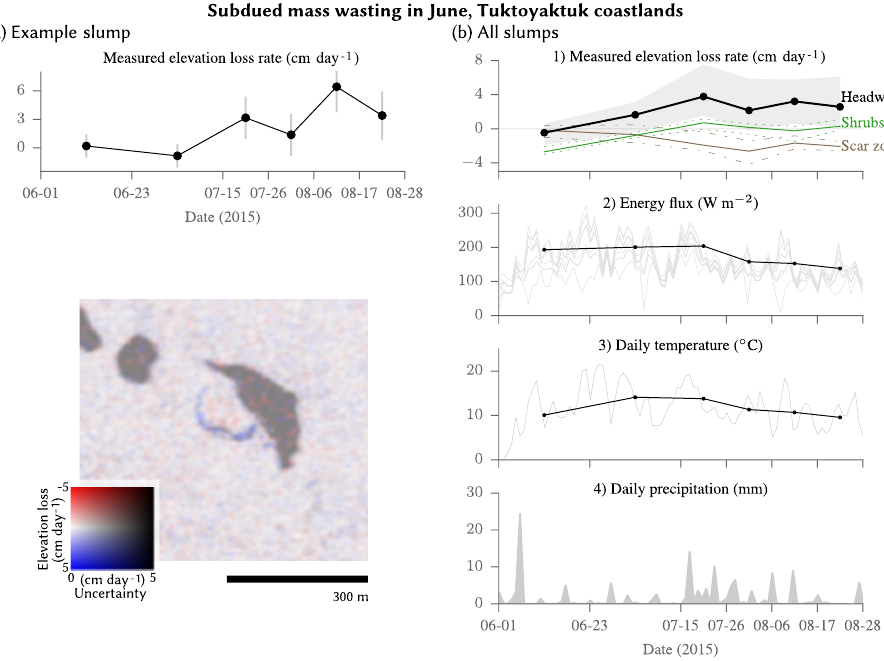
Figure 4. Observed time series of elevation losses in the Tuktoyaktuk coastlands. (a) Sub-seasonal elevation loss rates r at thaw slump 152 (see Fig. 3) are lower in June and early July than later in summer. The rates r are plotted halfway between the differenced successive TanDEM-X acquisitions (shown by ticks). The elevation losses occur at the arcuate headwall, as shown below (stacked losses r s between mid- July and August). (b) (1) Spatially aggregated sub-seasonal elevation loss rate r at thaw slumps covered by the ascending orbit ( N = 71; solid black line: median; grey area: interquartile range), along with observed rates over all slump scar zones with detected changes ( N = 25) and over patches with dense shrub cover ( N = 10). The observed elevation loss rate is plotted halfway between the earlier and the later acquisition (indicated by ticks). (2) Available energy for different headwall orientations (grey) and temporal averages for a horizontal surface (black). (3) Temperature at Inuvik (daily averages in grey; averages between subsequent acquisitions in black). (4) Daily precipitation measured in